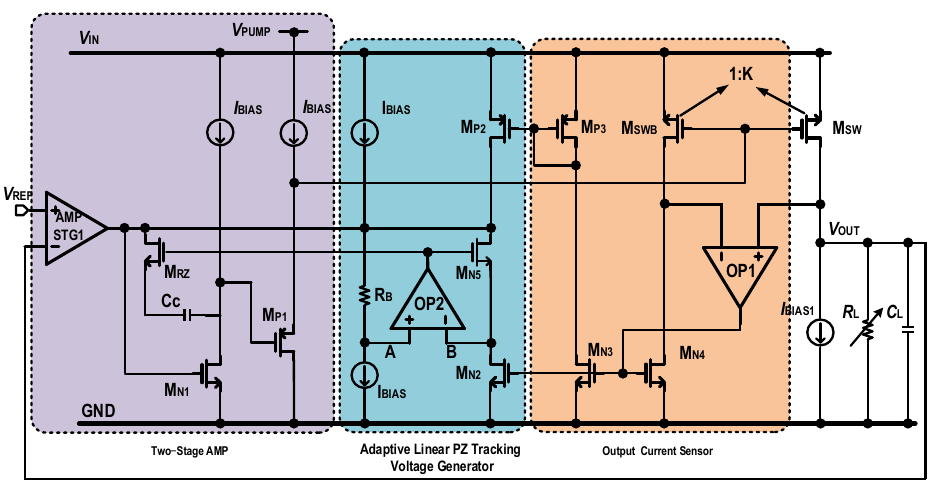
Figure 5. The detailed structure of the linear adaptive pole–zero compensation voltage regulation circuit.